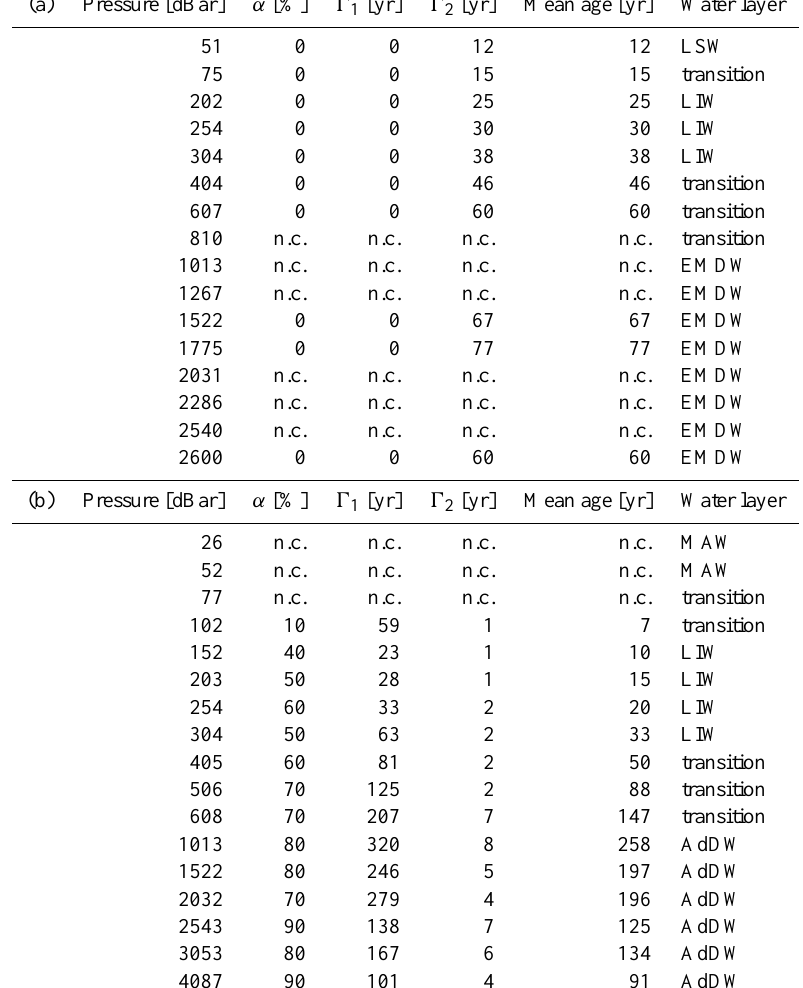
Table 4. Suggested mean age based on a 2IG-TTD at (a) station 290, (b) station 305, (c) station 317 and (d) station 323, where n.c. stands for non-constrained data points. The most prominent water layers are labeled according to the OMP of Hainbucher et al. (2013) including modified Atlantic water (MAW), Levantine surface water (LSW), Levantine intermediate water (LIW), eastern Mediterranean deep